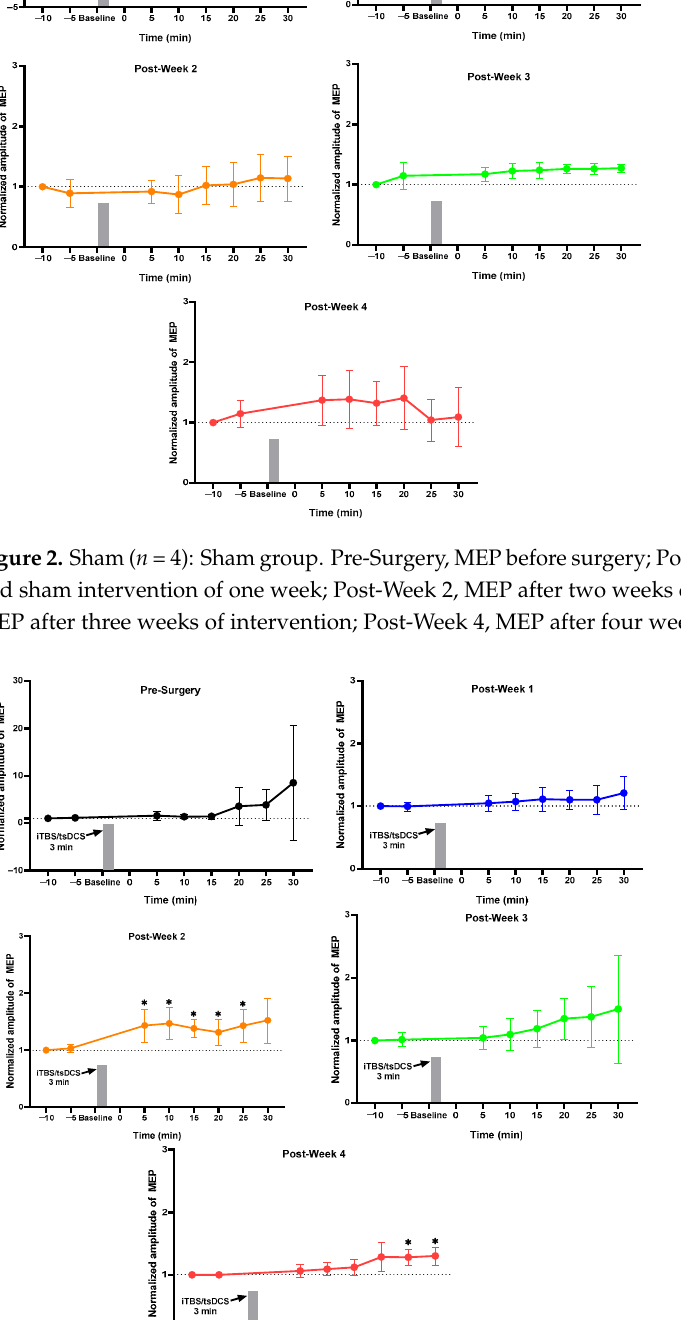
Figure 3. iTBS/tsDCS ( n = 4). iTBS/tsDCS (3 min). The level of significance was set to p < 0.050 *.